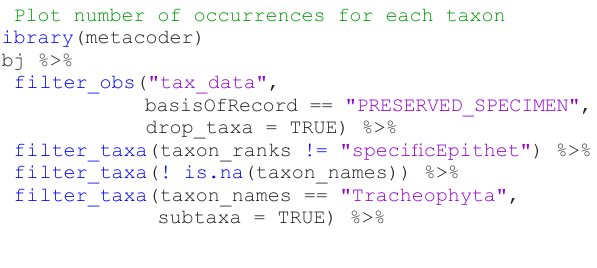
package that accepts the format. The plot is a taxo- taxmap nomic tree with color and size used to display the number of occurrences associated with each taxon (Figure